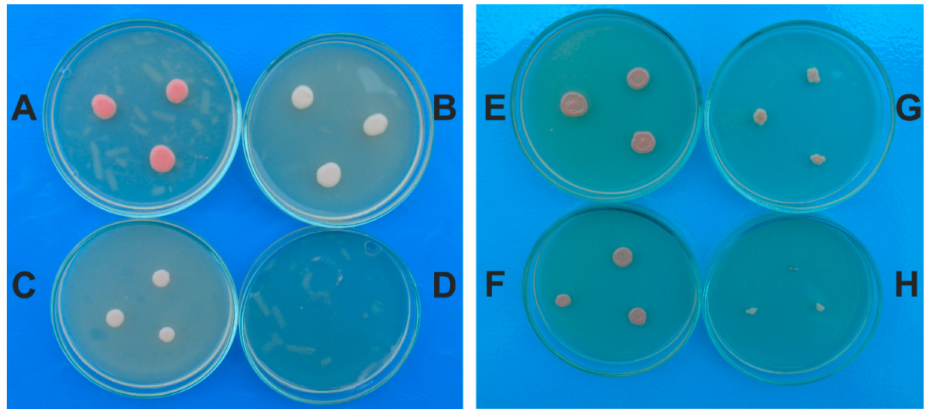
Figure 4. Colonies of R. mucilaginosa on SDA: with garlic extract 4% ( A ); with garlic extract 6% ( B ); with garlic extract 8% ( C ); with garlic extract 10% ( D ); control ( E ); with naftifine 0.1% ( F ); with naftifine 1.5% ( G ); with naftifine 3% (without colony) ( H